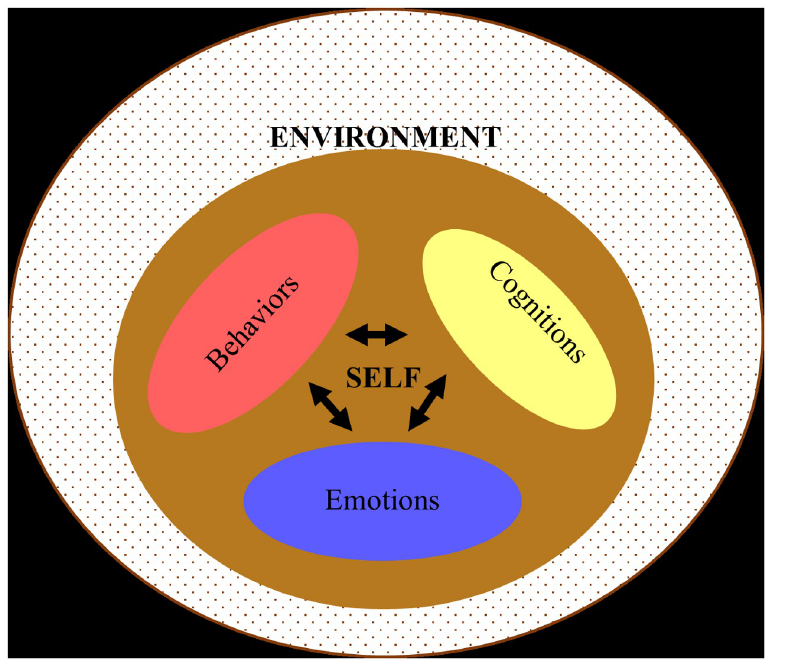
Fig 2. Study’s conceptual